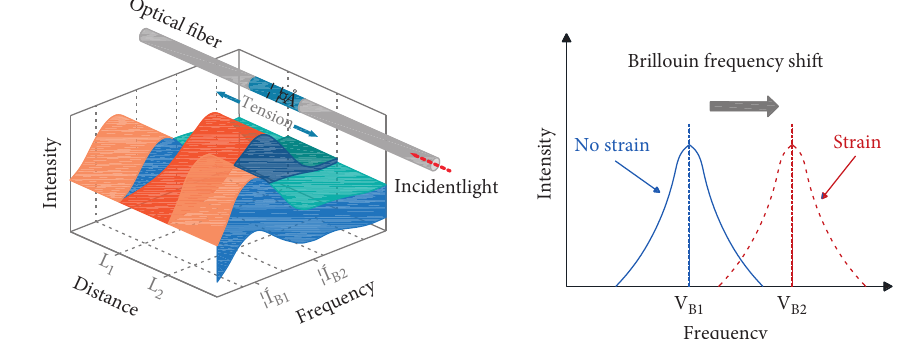
Figure 1: Monitoring principle of BOTDA.